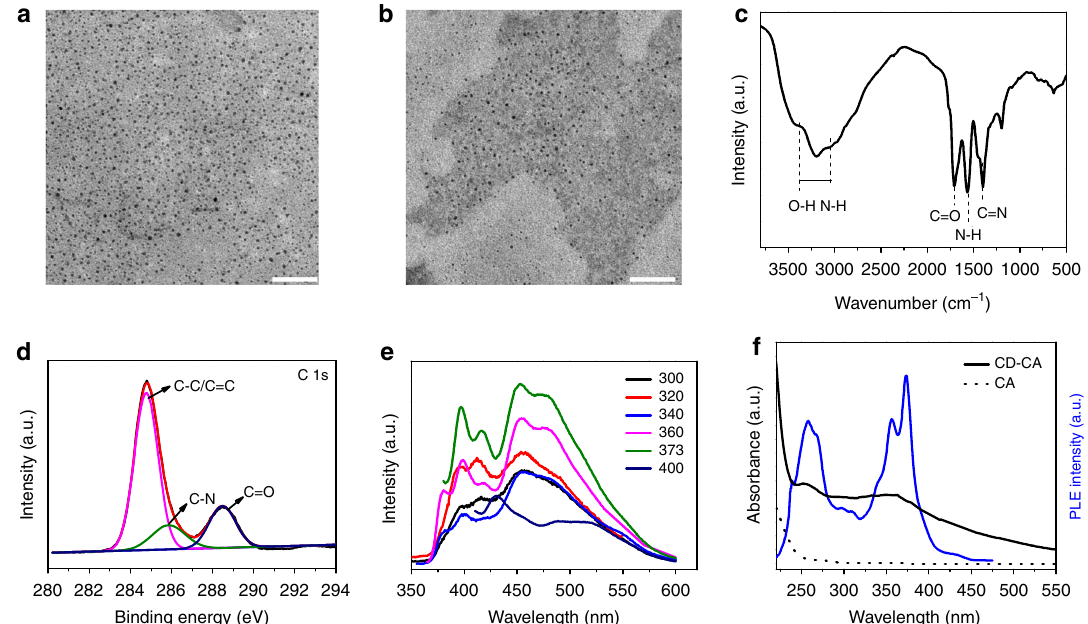
Fig. 2 Characterisation of the CDs and CD-CA powder. a TEM image of the CDs (scale bar, 50 nm). b TEM image of the CD-CA nanohybrid (scale bar, 50 nm). c FTIR spectrum of the CDs. d High-resolution C 1 s XPS spectrum of the CDs. e Phosphorescence spectra of the CD-CA powder under different excitation wavelengths. f Phosphorescence excitation spectrum (blue solid line) of the CD-CA powder with emission at 480 nm and the absorption spectra of the CD-CA power (black solid line) and the CA powder (black dotted a mean particle diameter of 4.8 nm (Supplementary Fig. 1a). An atomic force microscopy image of the CDs reveals that their topographic heights are in the range of 0.5 – 2.5 nm, suggesting that the prepared CDs are anisotropic (Supplementary Fig. 1b).